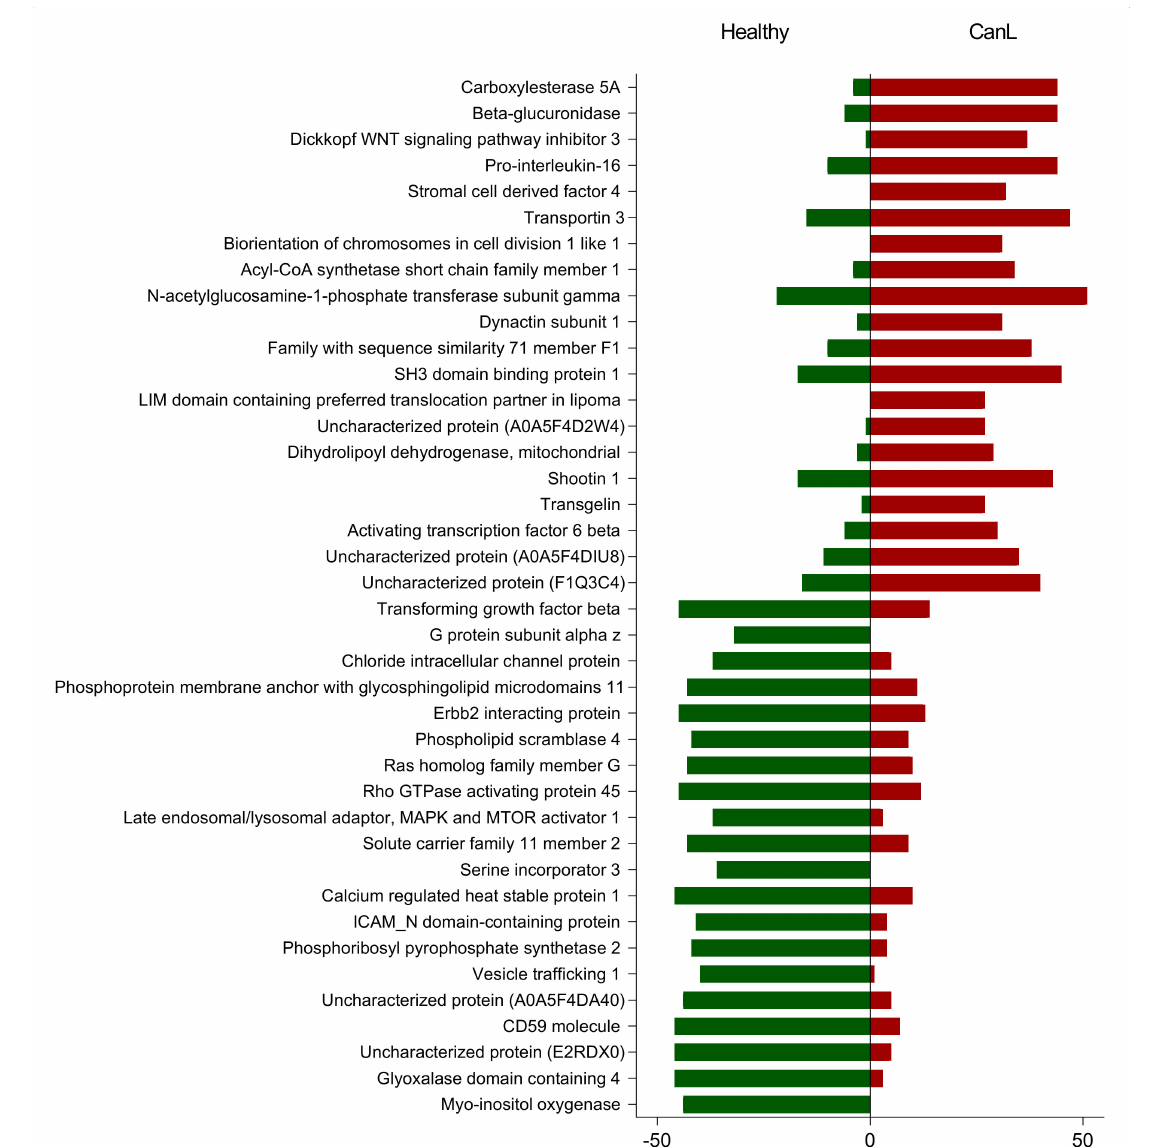
Figure 5. List of the 40 proteins that were mostly detected in either the injections from Healthy dogs (green columns) or CanL dogs (red columns). A total of 100 injections was considered (48 injections for 19 healthy samples and 52 for 20 CanL samples). For each protein identified, we included description and accession number from UniProt for uncharacterized